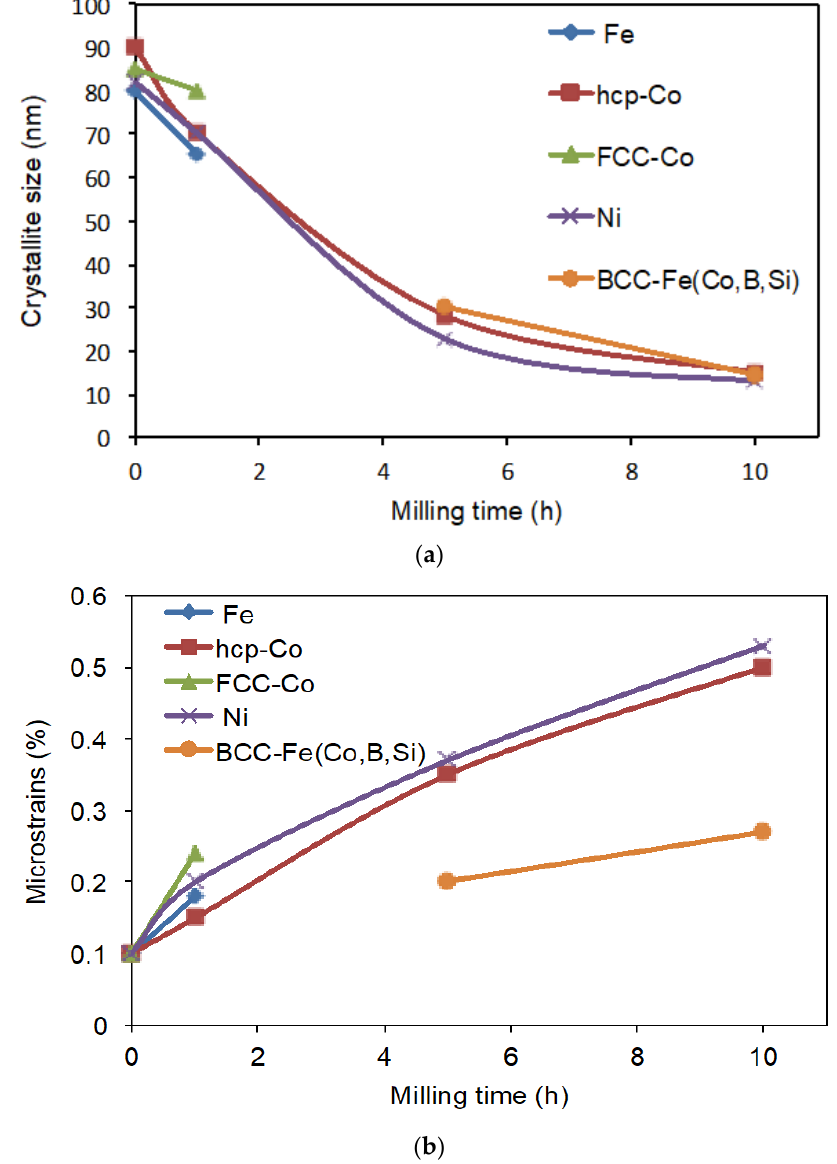
Figure 4. Dependence of the microstructure parameters of the Fe, FCC–Co, HCP–Co, Ni and BCC–Fe (Co,B,Si) as a function of milling time. ( a ) crystallite size and ( b ) microstrains.